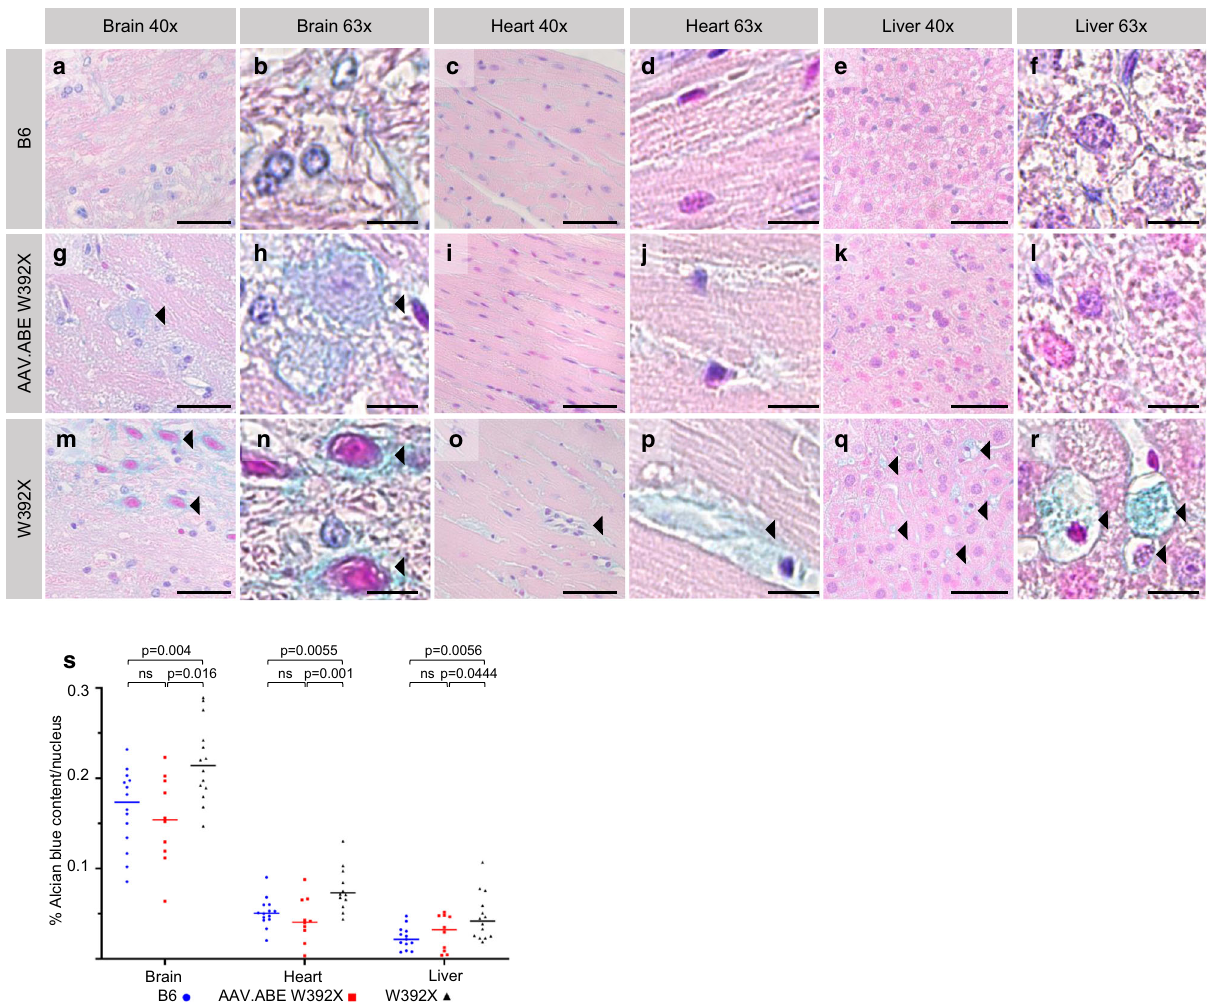
Fig. 3 In utero base editing diminishes aberrant tissue GAG deposition in brain, heart, and liver. a – s IHC with Alcian blue staining, which highlights accumulated GAGs, was performed in the brain, heart, and liver (three primary MPS-IH affected organs) in B6 ( N = 14), Idua- W392X mice prenatally injected with AAV.ABE.Idua ( N = 10), and uninjected Idua- W392X mice ( N = 14, except N = 12 for heart). Representative sections: 40x brain sections featuring axonal tracts and periaxonal cells near cerebellar peduncles ( a , g , m ); 63x brain sections featuring axonal tracts and periaxonal cells near cerebellar peduncles ( b , h , n ); 40x left ventricles ( c , i , o ); 63x left ventricles ( d , j , p ); 40x liver ( e , k , q ); and 63x liver ( f , l , r ). s Alcian blue staining was quanti fi ed and normalized to number of visualized nuclei per high power fi eld. Arrowheads denote Alcian blue staining of GAGs in vacuolated cells in the brain, the interstitial space in the heart, and in hepatocytes. ( a , g , m , c , i , o , e , k , q ) Scale bar = 50 µ m. ( b , h , n , d , j , p , f , l , r ) Scale bar = 10 µ m. Statistical analyses used Student ’ s t -test with α = 0.05. All tests two-sided. GAG glycosaminoglycans, AAV.ABE indicates AAV.ABE.Idua. Source data are provided as a Source Data fi